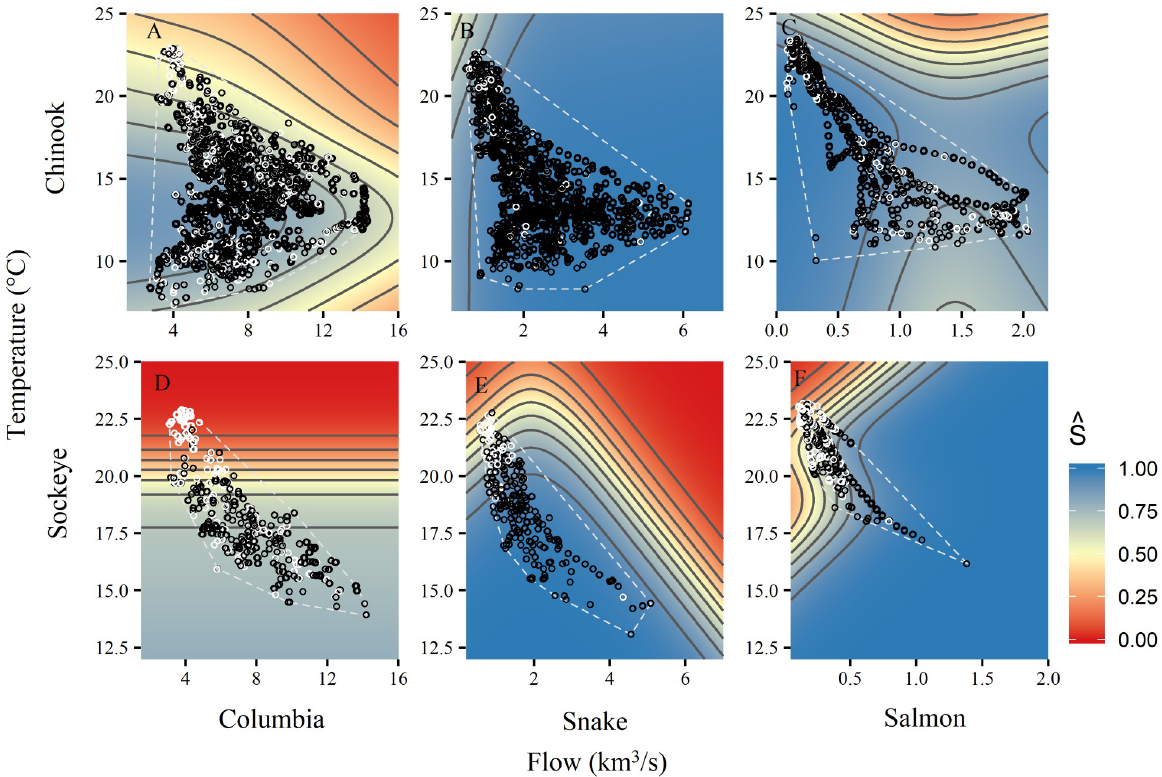
Fig 3. Conditional surfaces of model-predicted survival ( ^ S ) with variation in temperature and flow. Contour lines show incremental changes in predicted survival of 10%. The white polygons characterize the range of conditions fish experienced in the observation dataset for comparison to simulated conditions. All other variables were set at median values (or most common value for factors) to produce surfaces. Points indicate the combinations of temperature and flow at which individual fish were detected at reach entry and were either detected (black) or not detected (white)